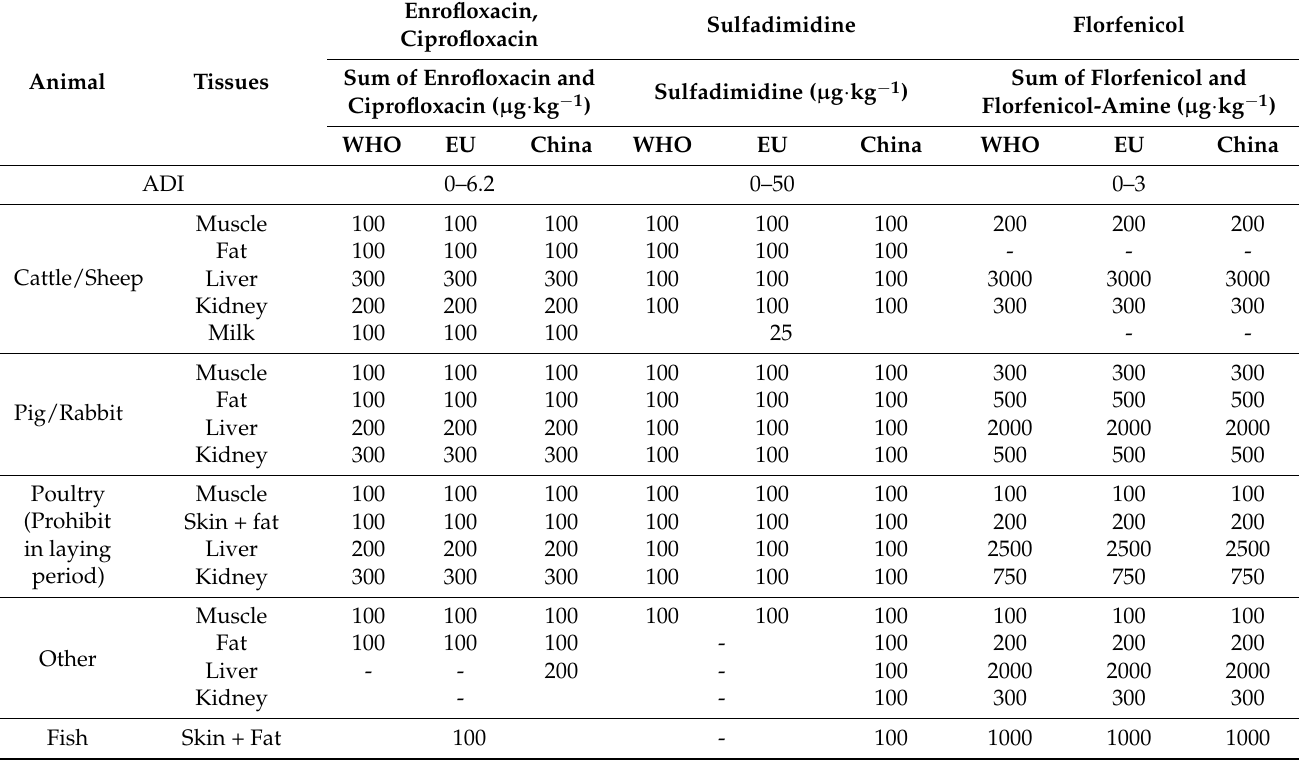
Table 1. Maximum residual limits (MRL) of the compounds